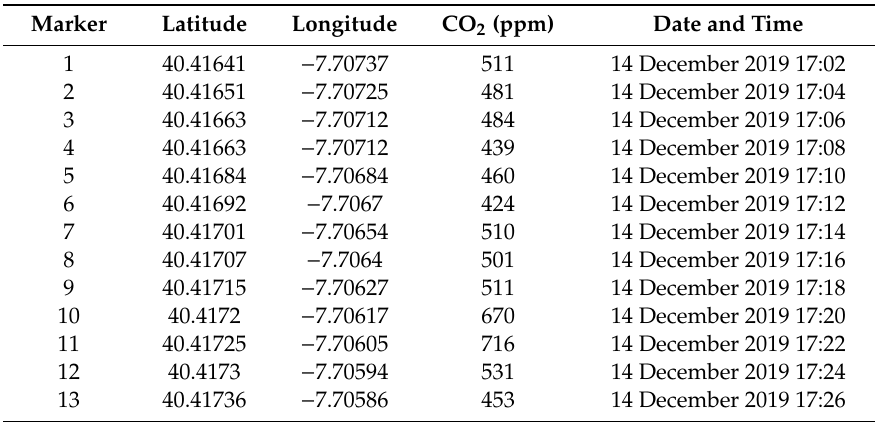
Figure 5. Mapping of CO 2 concentrations during the tests performed. Table 3. Measurement of CO 2 concentrations during the tests performed.